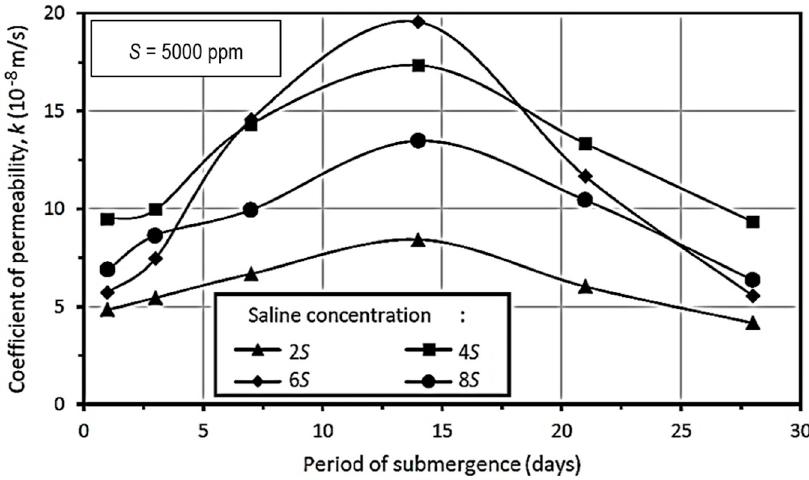
Figure 11. Variation of k with period of submergence.